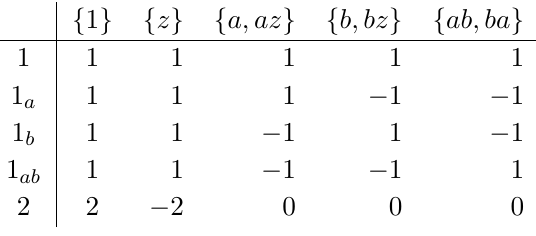
Table 2 . Character table of D 4 (without a